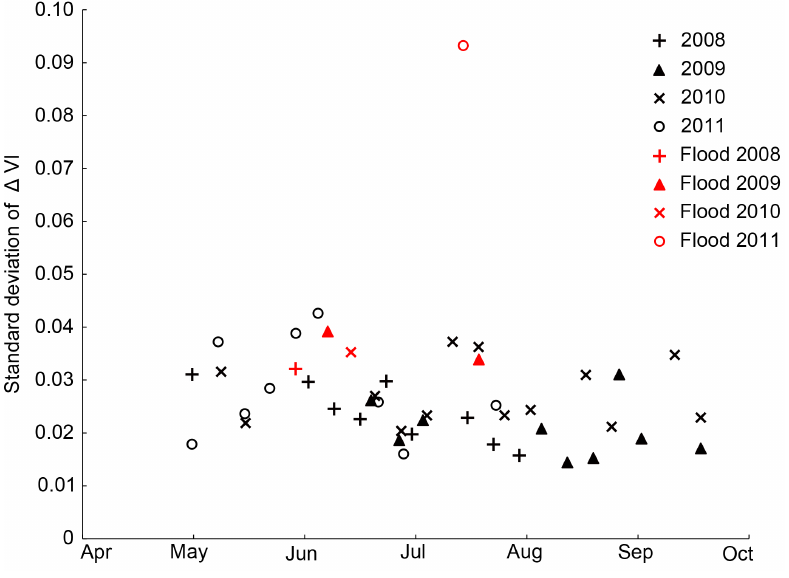
Figure 5. Comparison of the spatial standard deviation of (cid:49) VI change in response to floods and to normal hydrological conditions without occurrence of overbank flow (displayed VI values correspond to NDVI). (cid:49) VI was computed for periods of 14 days with discharge less than Q 1 and for the five major floods studied. Only pixels representing vegetation were considered (NDVI >